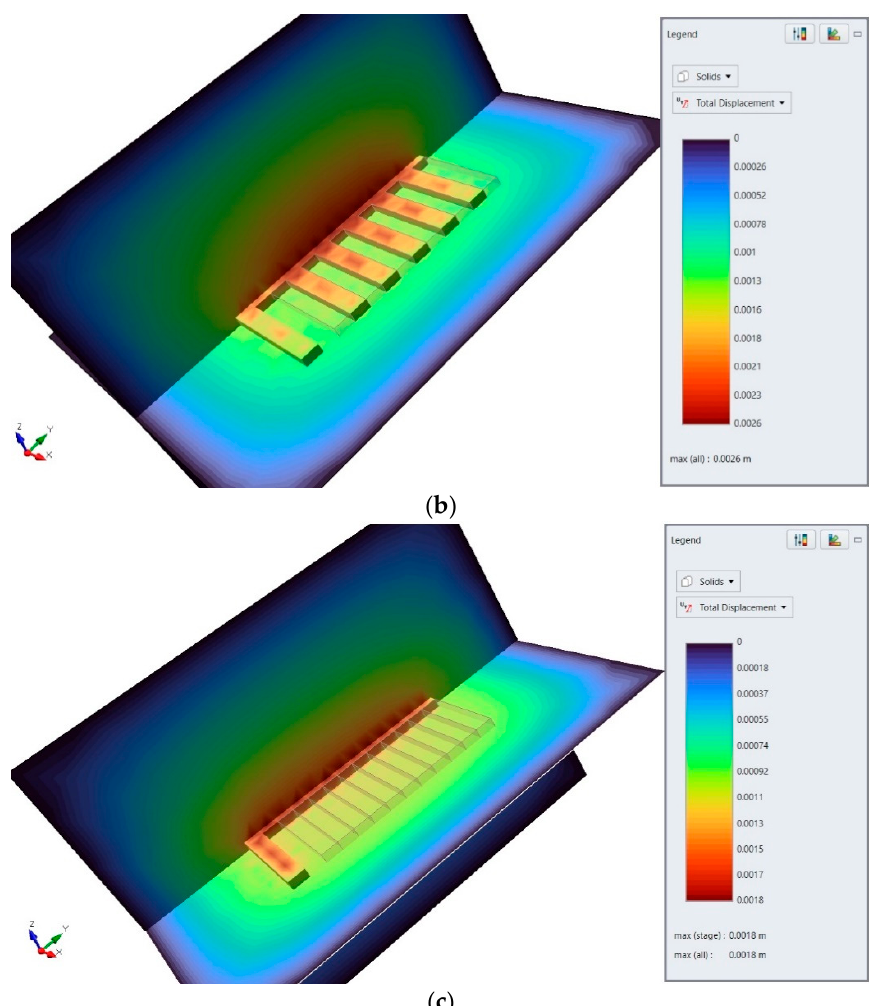
Figure 13. Total displacement for the mining field with 10% cement content in paste backfill: ( a ) second stage; ( b ) third stage; ( c ) fourth stage.